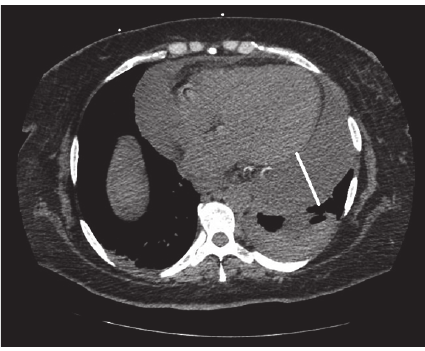
Figure 1: Axial CT chest showing a large pericardial effusion with a small left pleural